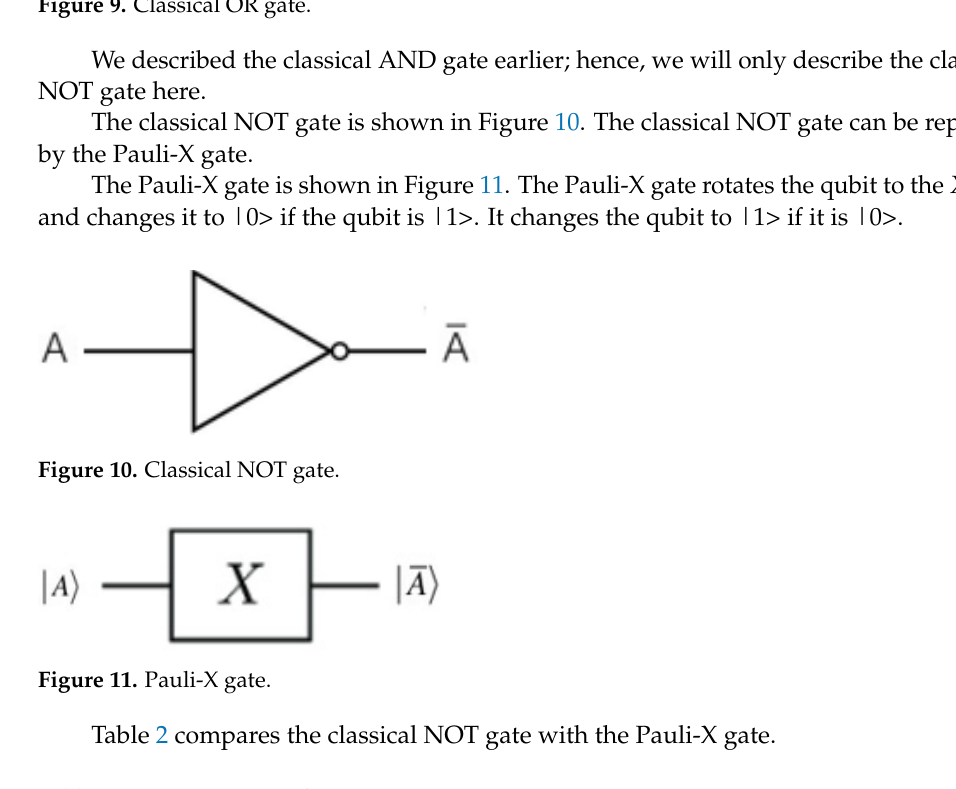
Table 2. NOT Gate vs. Pauli-X